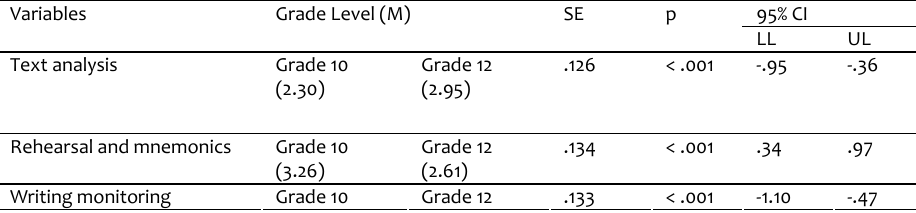
Table 4. Post Hoc Results of ANOVA of the Seven Selected Self-regulatory Strategies by Grade Levels (N